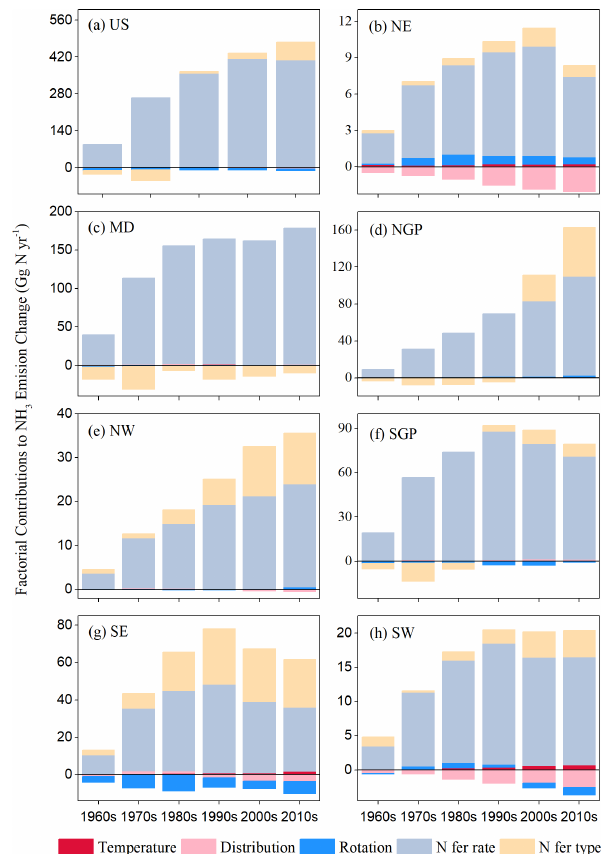
Figure 7. Decadal-average factorial contributions of temperature, cropland distribution, cropland rotation, N fertilizer use rate, and N fertilizer type to NH 3 emission change in the contiguous US and seven subregions. The seven subregions are the Northeast (NE), the Midwest (MD), the Northern Great Plains (NGP), the North- west (NW), the Southern Great Plains (SGP), the Southeast (SE), and the Southwest